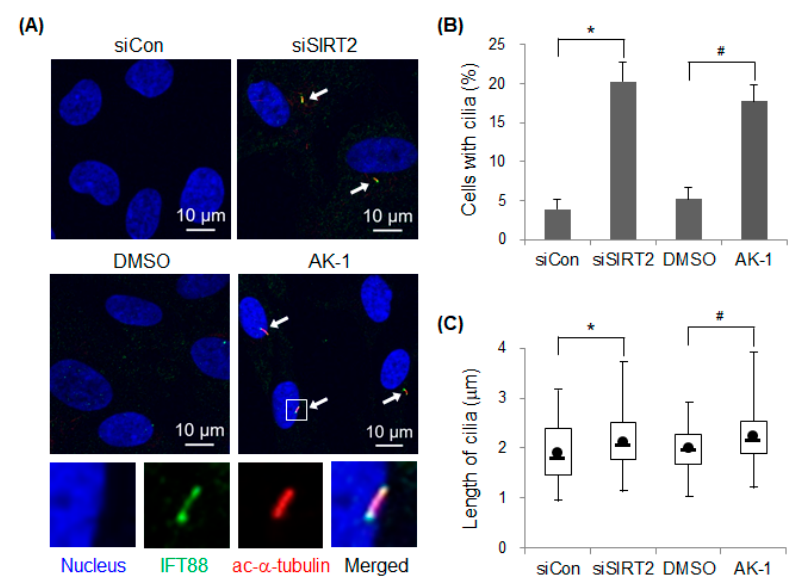
Figure 1. Suppression of SIRT2 increases ciliogenesis in the presence of serum. ( A , B ) hTERT-RPE1 cells were transfected with control siRNA (siCon) or SIRT2-targeting siRNA (siSIRT2), or treated with 0.1% DMSO or 10 μ M AK-1, a SIRT2-specific inhibitor, for 48 h. ( A ) Cilia were visualized by staining with antibodies specific for IFT88 (green) and α -tubulin-acetyl K40 (red), and nuclei were stained with Hoechst. Arrows indicate cilia and cilia within rectangle are enlarged below. Scale bars, 10 μ m; ( B ) The number of ciliated cells (out of 200 cells) was counted. The result is expressed as the mean ± standard error of the mean (SEM; n = 6); ( C ) The length of the cilia was measured and is represented in a box-and-whisker plot. A total of 60 cilia were observed from six-independent experiments. Boxes represent interquartile range; whiskers, minimum and maximum values; circles, average values; line, median values. * p < 0.05 and # p < 0.05; significantly different from siCon-transfected and DMSO-treated cells, respectively (unpaired Student’s t -test).